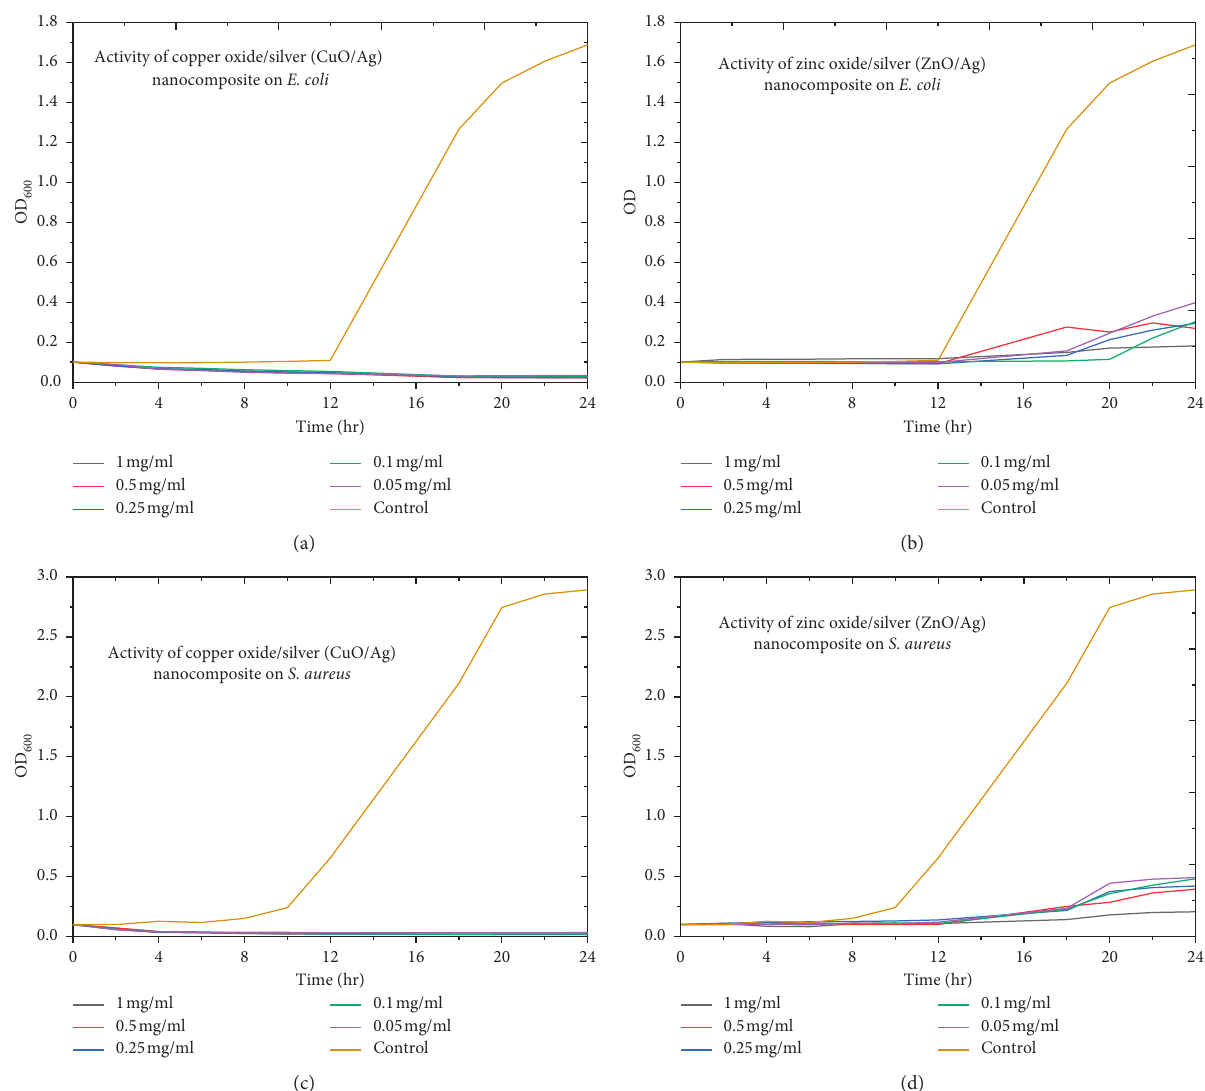
Figure 18: Kinetic growth study on the antibacterial activity of (a) CuO/Ag against E . coli , (b) ZnO/Ag against E . coli , (c) CuO/Ag against S. aureus , and (d) ZnO/Ag against S . aureus